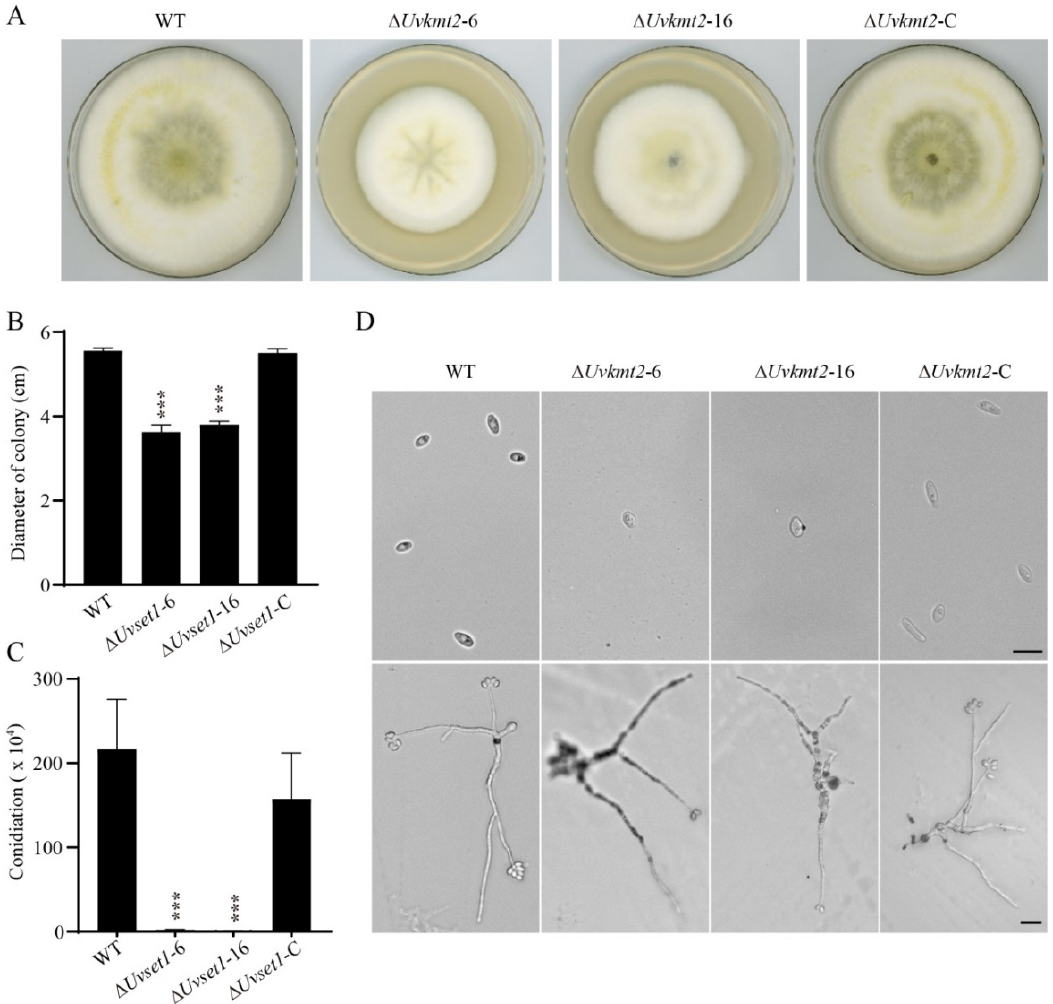
Figure 3. UvKmt2 is required for growth, conidiation, and formation of secondary spores in U. virens . ( A ) Colonies of the WT, Δ Uvkmt2 , and complemented strains cultured on PSA at 28 °C in the dark. Photographs were taken at 14 d. ( B ) Statistical analysis of the colony diameters of indicated strains. ( C ) Knockout of UvKMT2 gene led to highly decreased conidiation. The conidial concentration was determined after being cultured in PS medium for 7 d. Values represent the mean ± SD from three independent biological replicates. ( D ) Conidial germination of U. virens on water agar plates. A volume of 5 μL of conidial suspensions (1 × 10 6 conidia/mL) was inoculated and incubated at 28 °C for 3 d. Scale bar, 5 μm. Error bars represent the standard deviations. *** indicates p value < 0.001 compared to the WT.